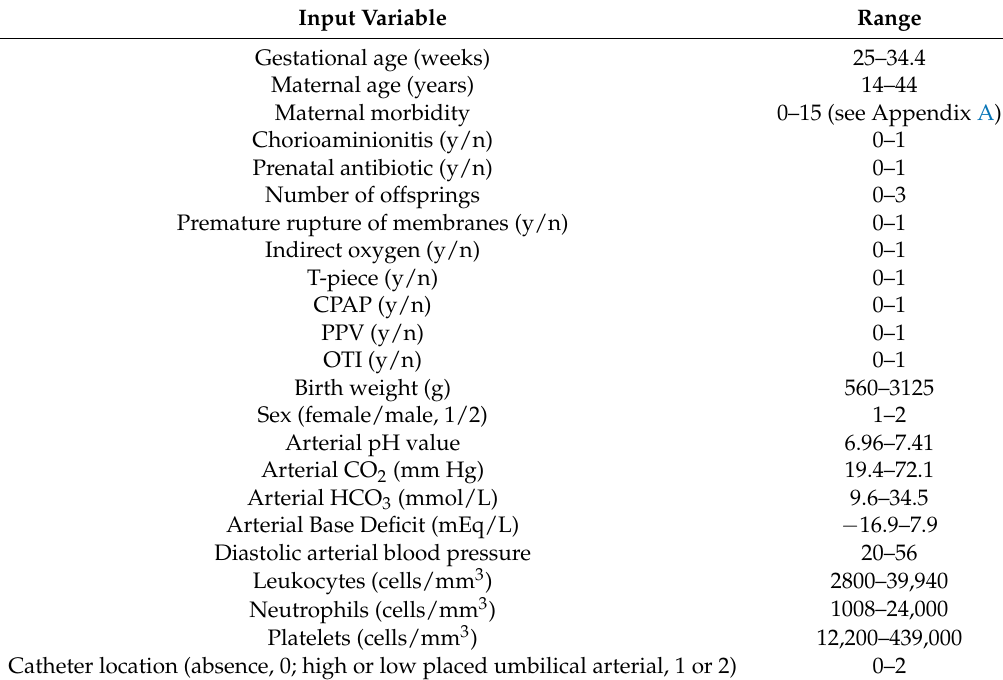
Table 3. Input range conditions in the IP ANN model at